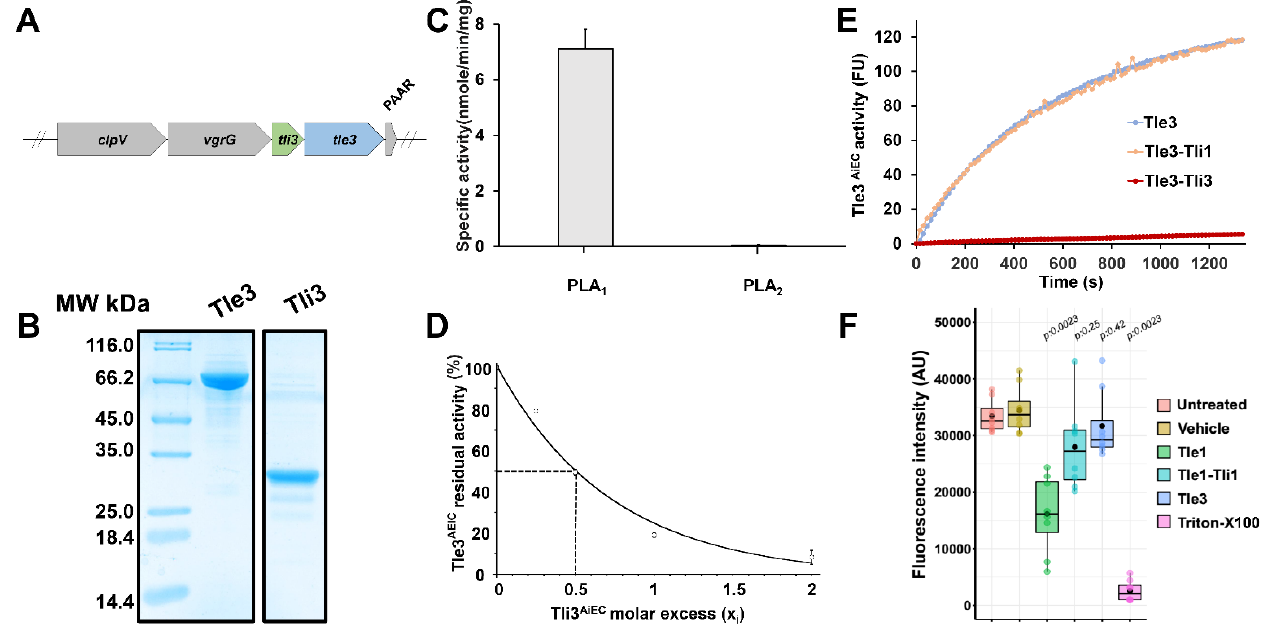
Figure 1. Biochemical characterization of recombinant Tle3 AIEC . ( A ) Schematic representation of the genetic organization of vgrG, tli3 and tle3 genes from AIEC LF82 T6SS-1 cluster. The LF82_434 and LF82_435 genes encoding Tli3 AIEC and Tle3 AIEC are indicated in green and blue, respectively. The clpV, vgrG and PAAR T6SS-1 genes are indicated in grey. ( B ) The SDS-PAGE analysis of the purified Tle3 AIEC and Tli3 AIEC proteins (10 µg) after Coomassie blue staining. Molecular weight markers from Euromedex (in kDa) are indicated on the left. ( C ) Specific phospholipase A1 (PLA1) and A2 (PLA2) activity measurements of the Tle3 AIEC protein using fluorescent phospholipids. Specific activities were calculated from the velocity slope obtained for 25 min using 20 µg of purified protein. Data are expressed as mean of three, from three independent assays (CV% < 5%). ( D ) Inhibition studies with Tli3 AIEC were performed by incubating 30 µg of Tle3 AIEC with various molar ratio of Tli3 AIEC (x i = 0, 0.25, 0.5, 1 and 2). The rate of hydrolysis of PED-A1 by purified Tle3 AIEC at 20 °C in presence of increasing concentrations of Tli3 AIEC was plotted against the molar excess of Tli3. ( E ) Cross-inhibition studies with Tli1 EAEC were performed by incubating 20 µg of Tle3 AIEC ( ) with a molar ratio of